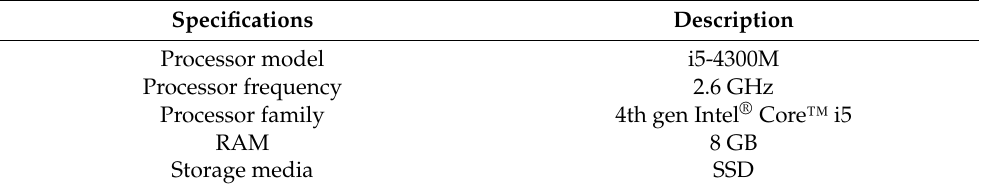
Table 7. Computer Specifications.